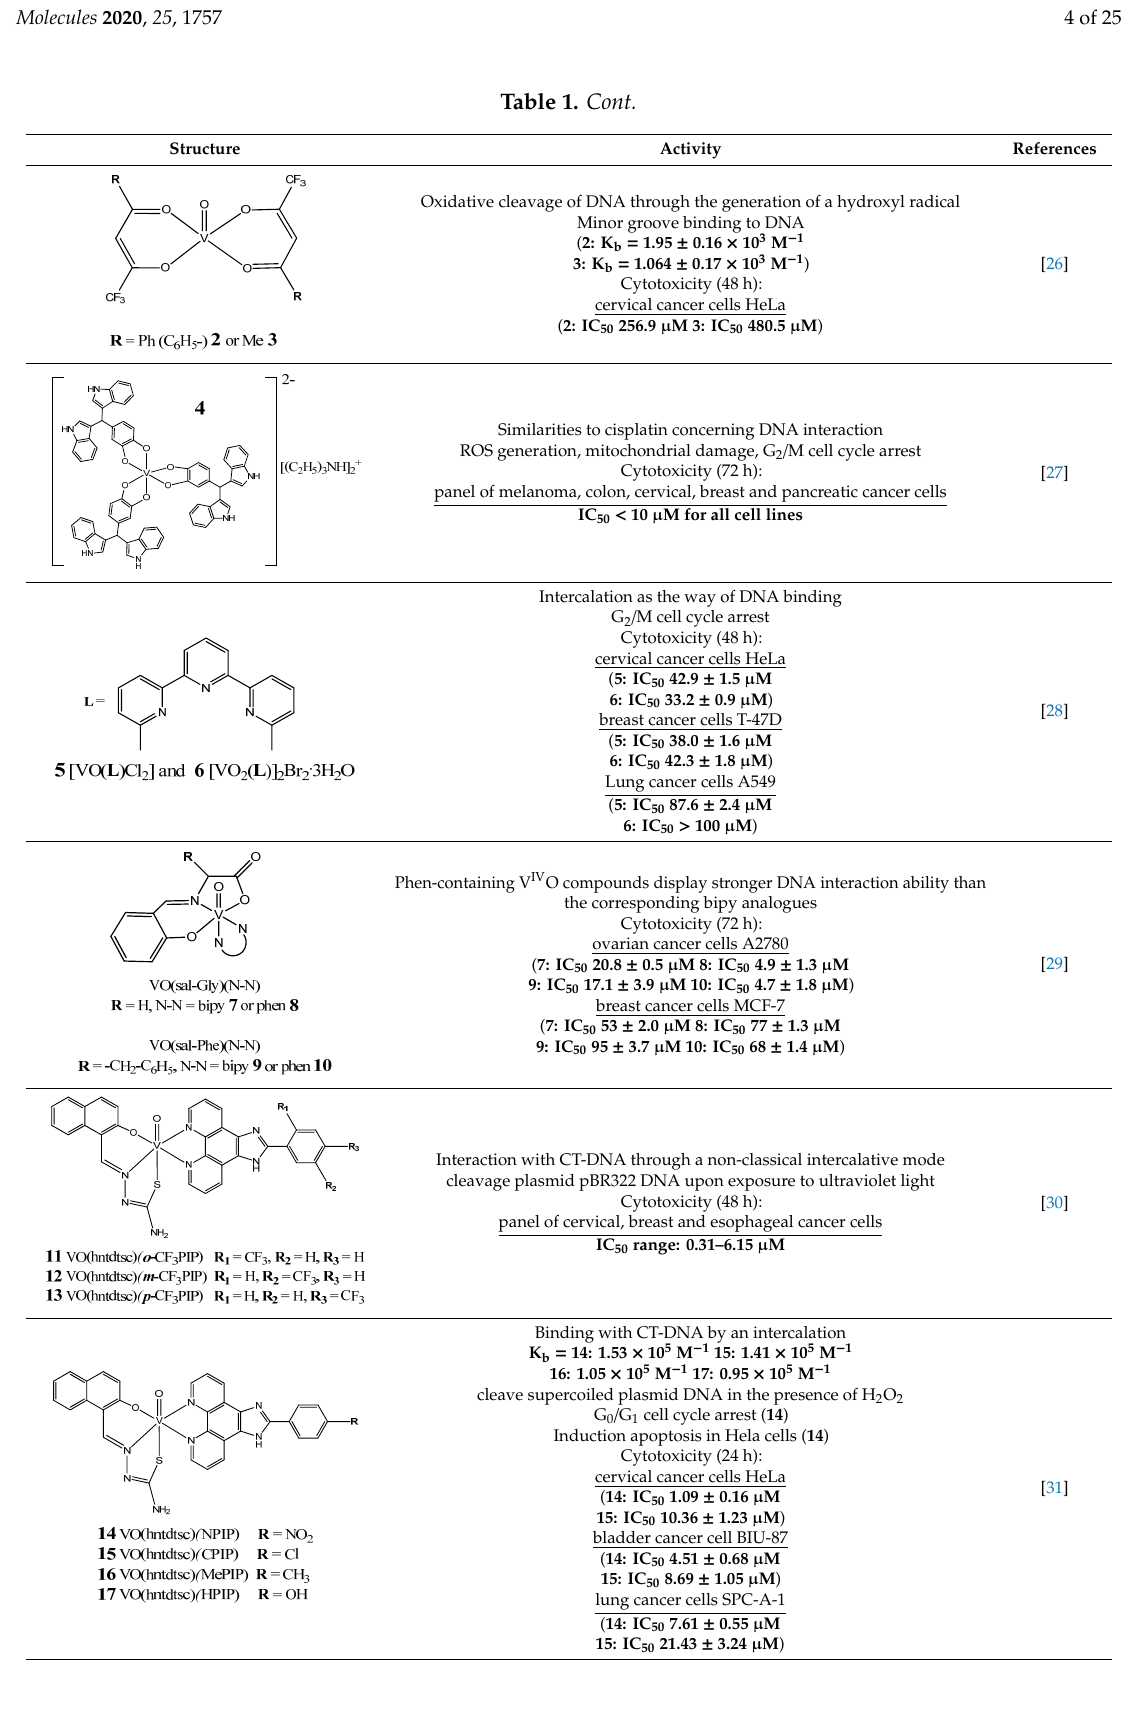
Table 1. Cont. Molecules 2020 , 25 , 1757 Structure Activity References Oxidative cleavage of DNA through the generation of a hydroxyl radical Minor groove binding to DNA [26[